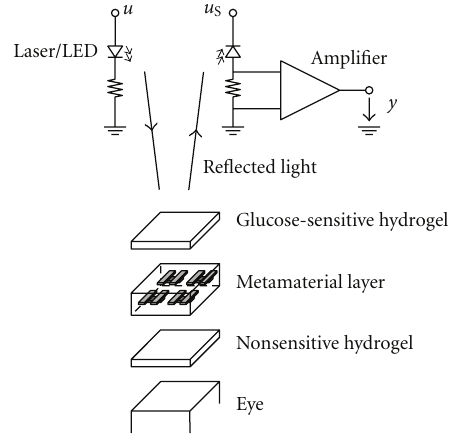
Figure 1: Schematic of the proposed design.